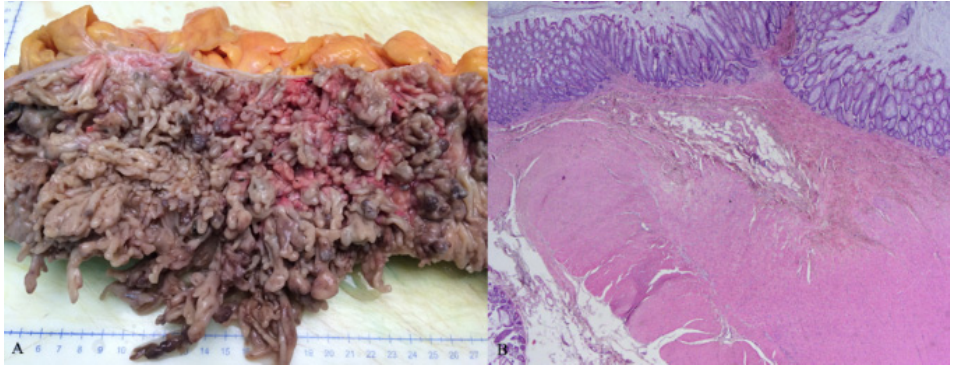
Figure 5. ( A ) Macroscopic view of surgical specimen of colon with giant inflammatory polyps; ( B ) HE 20×, microscopic view of colonic specimen without transmural inflammation.